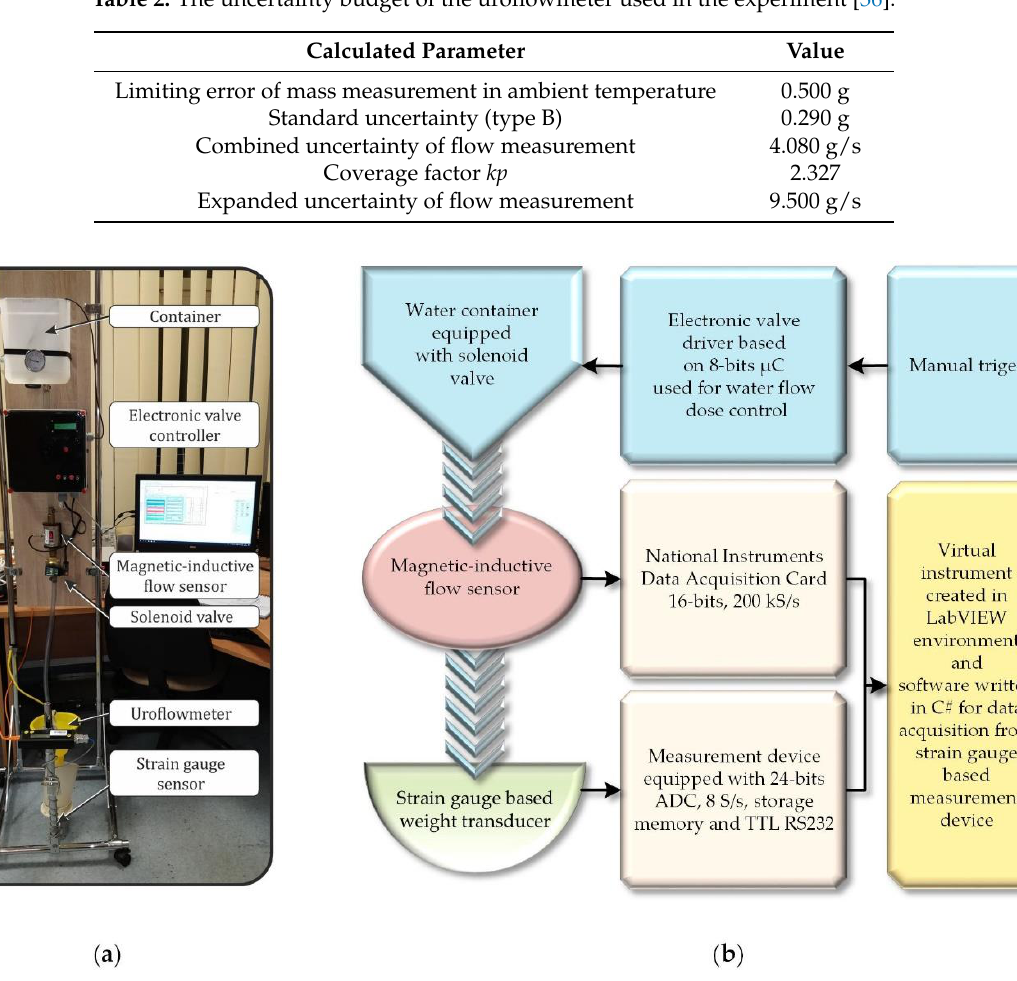
Table 2. The uncertainty budget of the uroflowmeter used in the experiment [36].